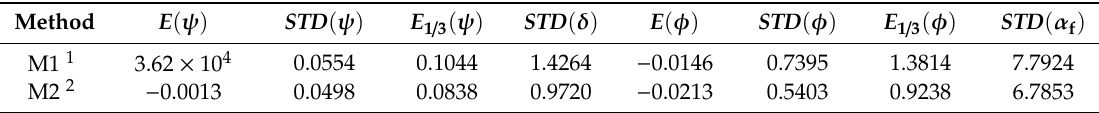
Figure 5. Simulation curves of the ship roll-yaw motions using LQR/ H ∞ -SFMPC control law. Table 3. Statistical simulation results of the ship roll/yaw motions using different control law at the encounter angle of 90°.